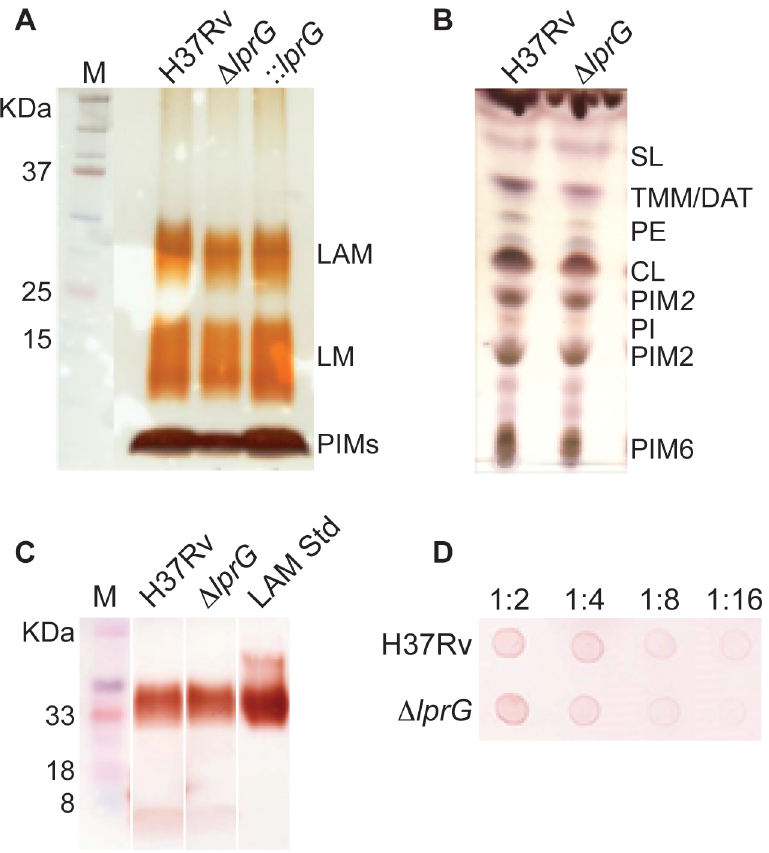
Fig 1. The lprG mutant has normal LAM content in the cell envelope. (A) SDS/PAGE analysis of phosphatidylinositolmannosides (PIMs), lipomannan(LM) andLAM prepared fromwild-type (H37Rv), lprG mutant ( Δ lprG ),and Δ lprG complementedwith lprG -Rv1410c (:: lprG ). LM andLAM extracted from equal amounts of bacterial cells were separated on a 10 – 20%Tricinegel andvisualizedby periodic acid/Schiff reagent staining. (B) Thin-layer chromatograms of totallipids extractedfrom H37Rv and Δ lprG . Thesame amounts of total lipids extract frombacilli grown inGAS medium were loaded for each strain. Thin-layer chromatogram plates were runinthesolvent system CHCl 3 /CH 3 OH/H 2 O (65:25:4,by vol.) and revealedwith α -naphthol. SL, sulfolipid; TMM, trehalose monomycolates; DAT, diacyltrehaloses; PE, phosphatidylethanolamine; CL, cardiolipin; PIM 2 , phosphatidylinositoldimannoside;PI, phosphatidylinositol; PIM 6 , phosphatidylinositol hexamannosides. (C) SDS/PAGE immunoblot for LAM analysis inH37Rv and Δ lprG cellular extracts. Extracts normalizedto proteinconcentrationwere separatedona 15%SDS/PAGE gel andtransferredto PVDF membrane. Theblot was blocked, andthenstained with anti-LAM pAb ( α -LAM) followedby goat anti-rabbit IgG-HRP secondary antibody. The blot was washedand imaged after adding 30%3,3 ’ -diaminobenzidine tetrahydrochloride solution plus 0.0005%H 2 O 2 . LAM Std, purifiedH37Rv LAM standard. Lanes shown formed part of a larger gel. (D) Spotimmunoblot for analysis of capsular α -glucan. Capsular contentextracted from equal numbers of bacteria were spotted on PVDF membraneand stained with goat anti-phosphatidylinositol-glycans pAb followedby donkey anti-goat IgG-HRP secondary antibody. The membranewas developed andimagedas describedinC. Dilutions of extract spotted on membraneare shown. Data is representative of two independent